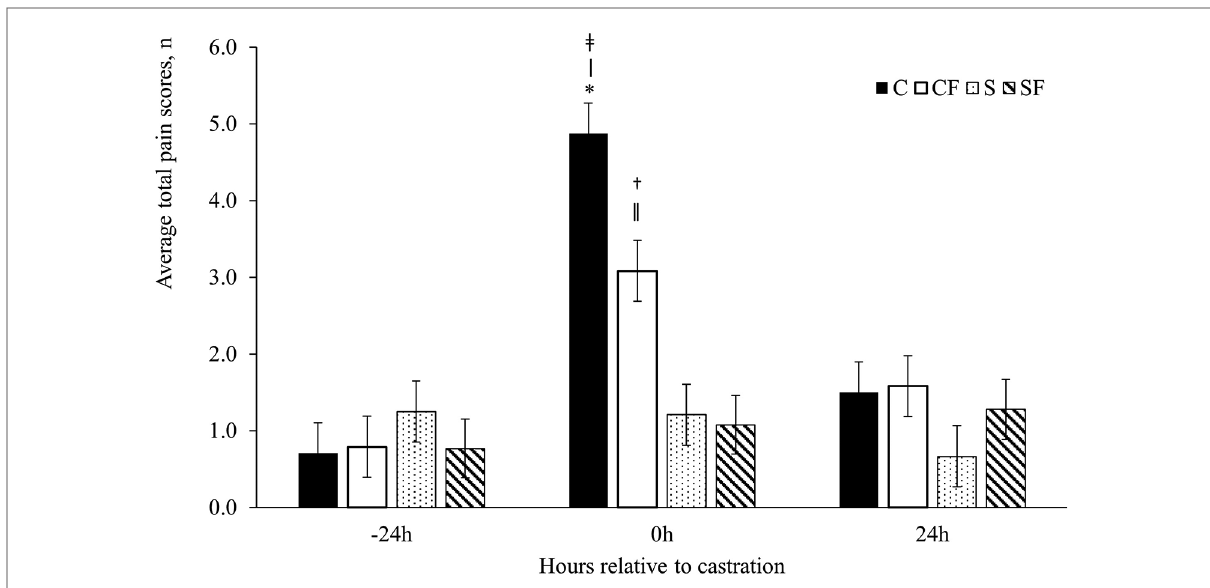
FIGURE 2 Mean±SEM total pain scores for piglets in the C, CF, S and SF groups. Timepoint ( P <0.0001), treatment ( P <0.001) and treatment by timepoint ( P < 0.0001) effect. Pairwise comparisons with P ≤ 0.03: ǂ C vs. SF; ǀ C vs. S; † CF vs. SF; ǁ CF vs. S. Pairwise comparisons with P ≤ 0.05: * CF vs. C.